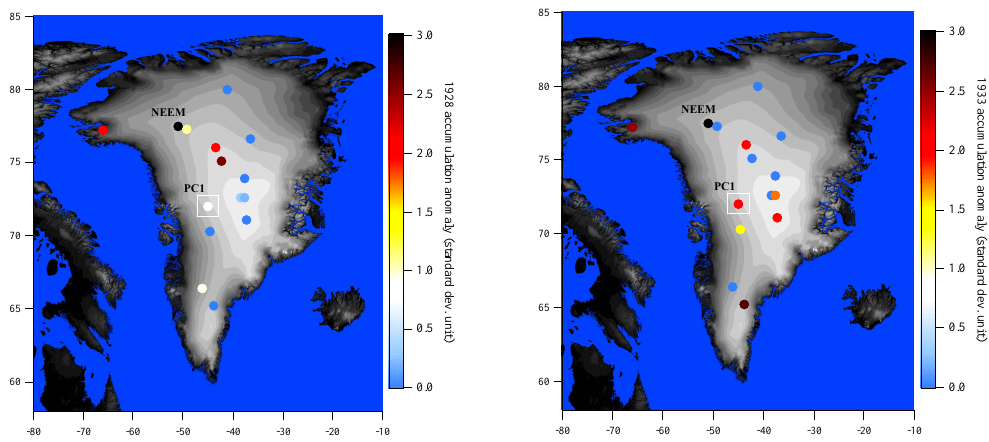
Figure 14. Accumulation anomalies during 1928 and 1933 with respect to the average values of 1898–1927, in standard deviation units (scaled to the standard deviation of accumulation in 1893–1927), for 1928 (left) and 1933 (right), as a function of the month (angle).